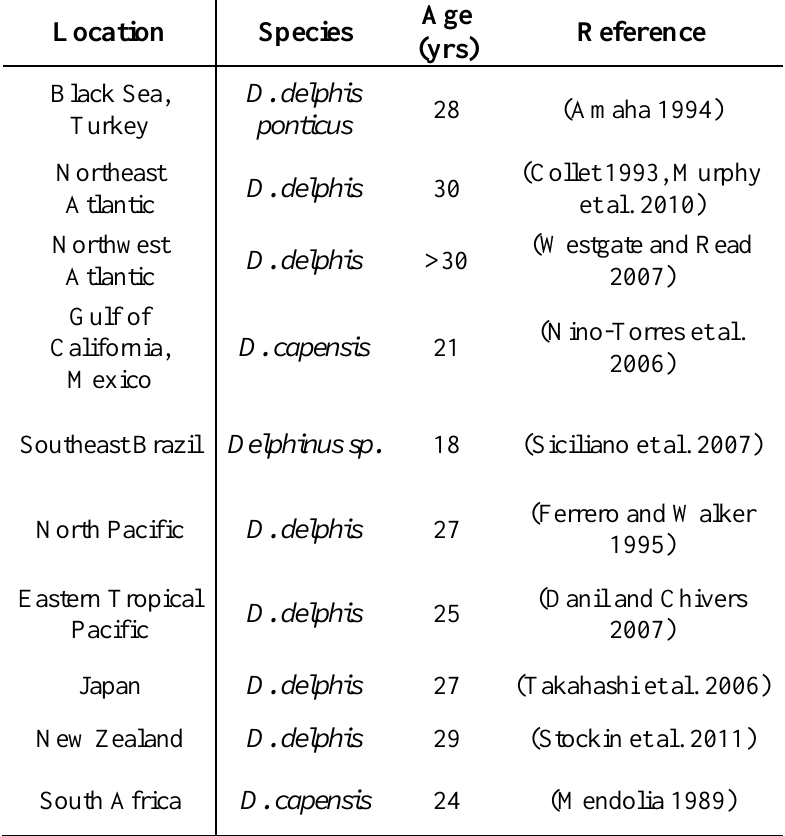
Maximum age estimates for common dolphin populations